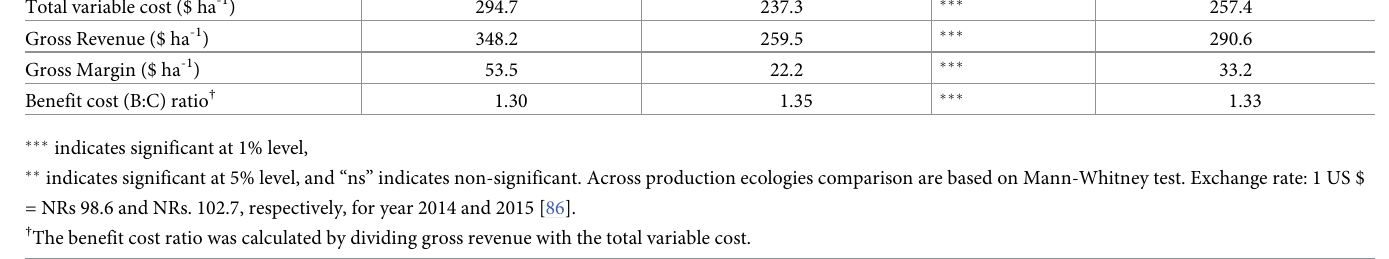
��� indicates significant at 1% level, �� indicates significant at 5% level, and “ns” indicates non-significant. Across production ecologies comparison are based on Mann-Whitney test. Exchange rate: 1 US $ = NRs 98.6 and NRs. 102.7, respectively, for year 2014 and 2015 [86]. † The benefit cost ratio was calculated by dividing gross revenue with the total variable